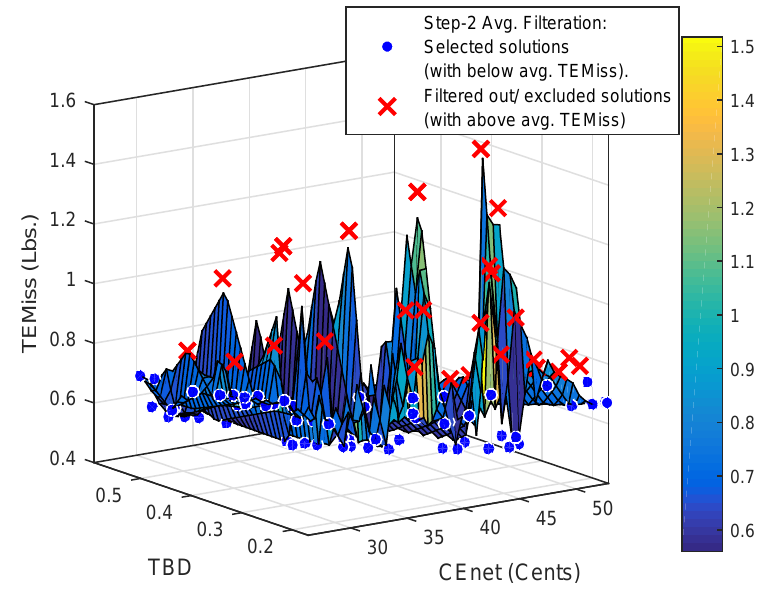
Figure 16. Application of AVCF to screen out the trade-offs with larger TEMiss